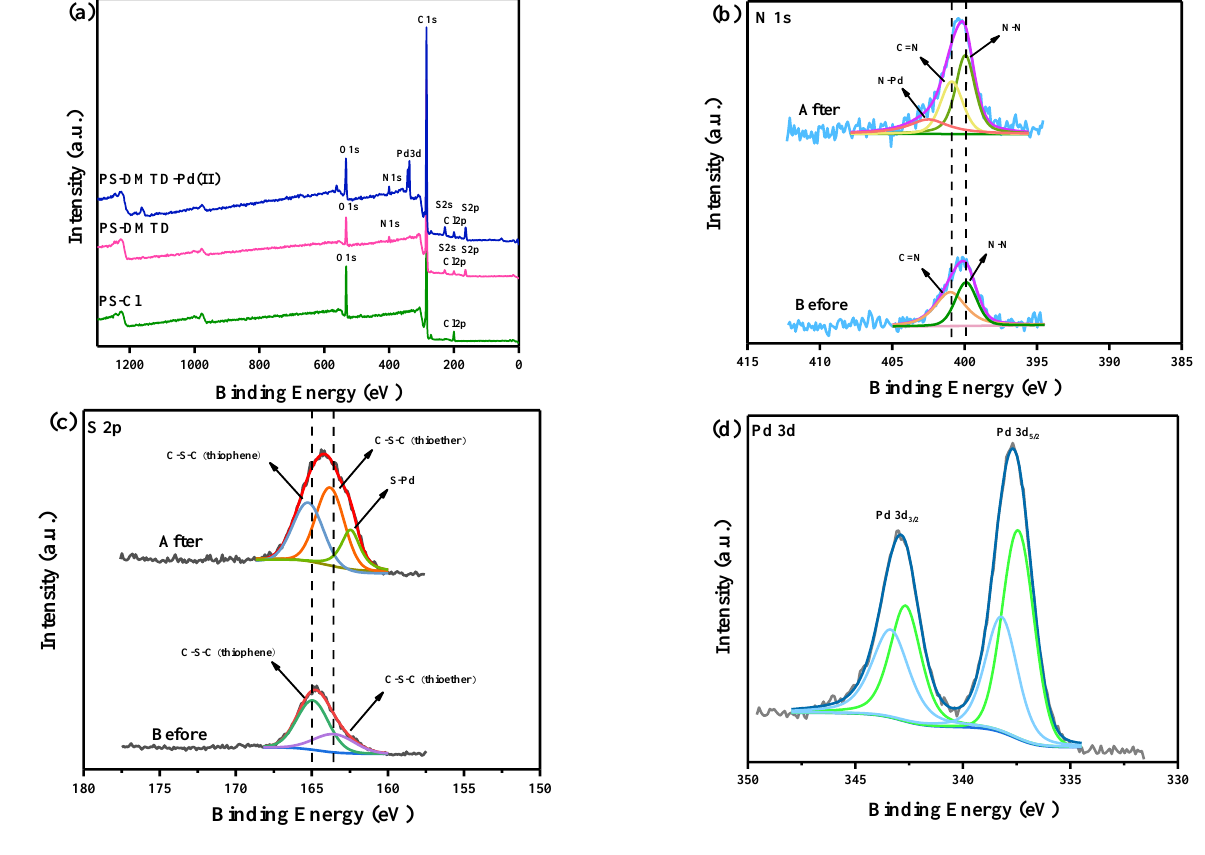
Figure 2. XPS spectra analysis: ( a ) full spectra of PS-Cl, PS-DMTD and PS-DMTD-Pd (II), ( b ) N 1s, ( c ) S 2p, and ( d ) Pd 3d. ( c ) S 2p, and ( d ) Pd 3d.